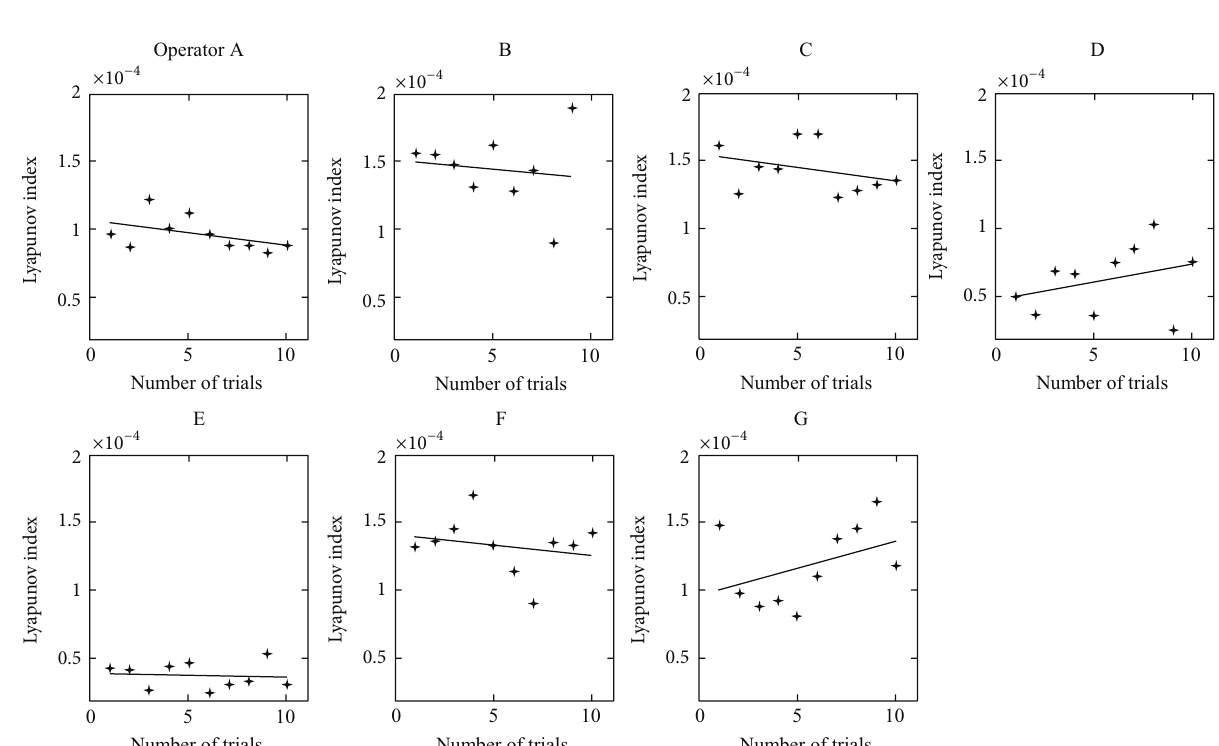
of all operators. vrri